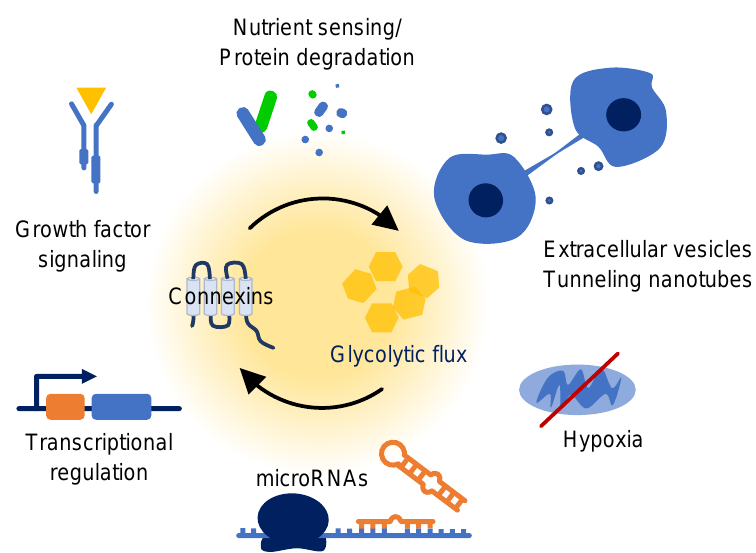
Figure 4. Emerging connections between connexin regulation and glucose metabolism. Data for some relationships is limited in cancer and requires continued research to better define the significance of these associations, which are likely to exhibit interdependence.